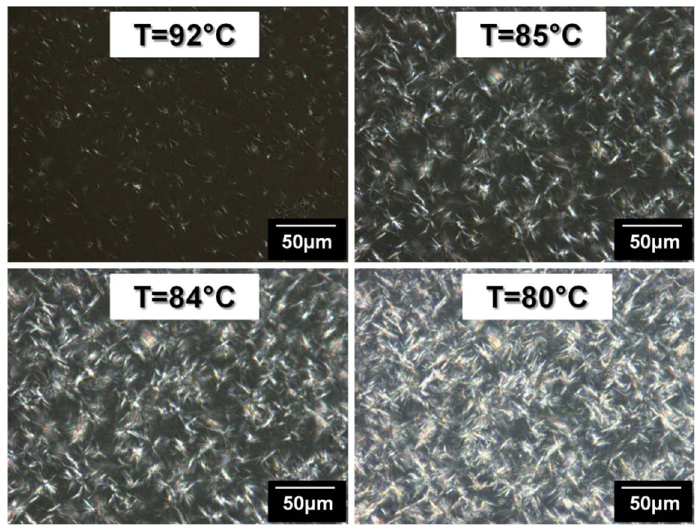
Figure 16. PE spherulite crystallization for PE-b-PEG A (23 wt. % PEG) observed by optical microscopy in combination with polarized light during a cooling ramp.